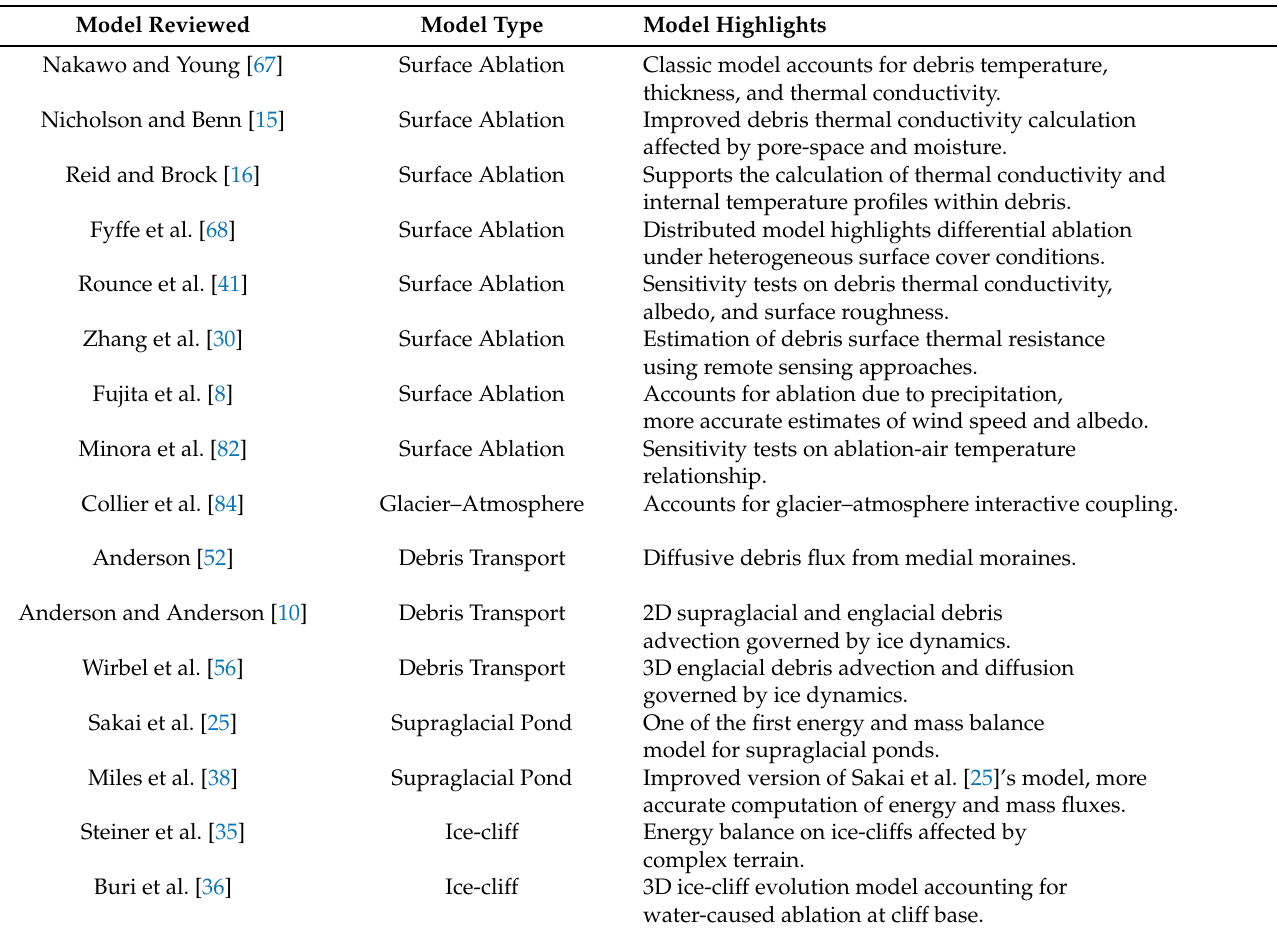
Table 1. Summary and comparison of the reviewed numerical models for debris-covered